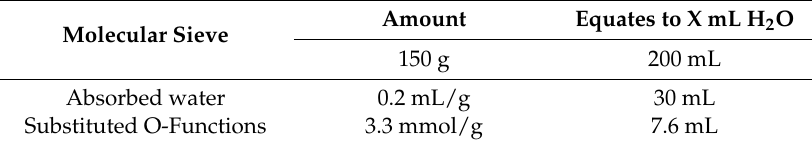
Table 5. Parameters of the molecular sieve separation method.